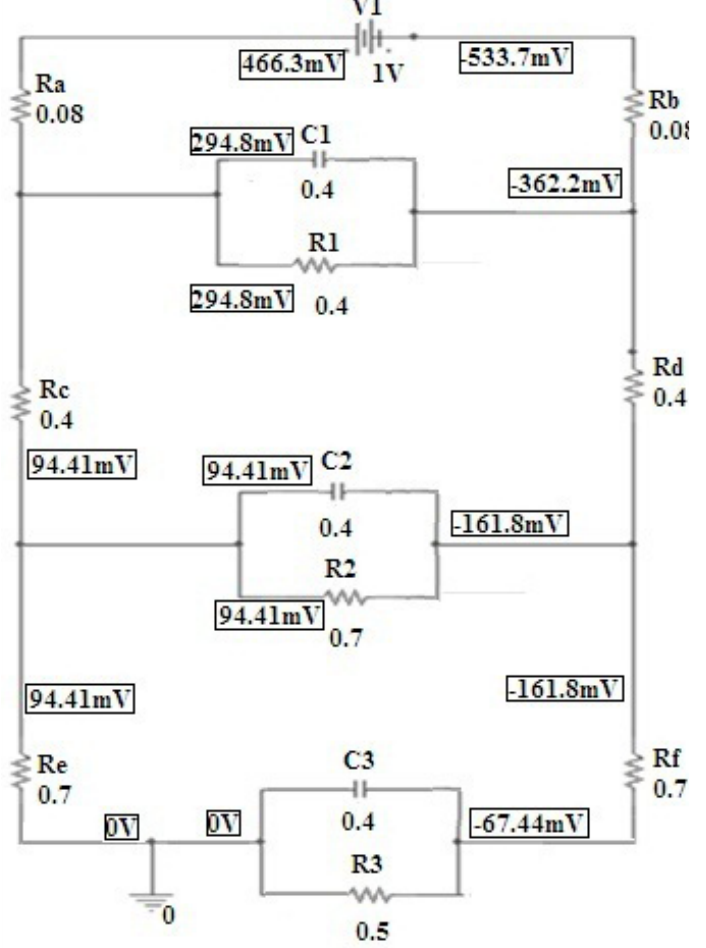
Figure 7. Output Voltage in the Network for